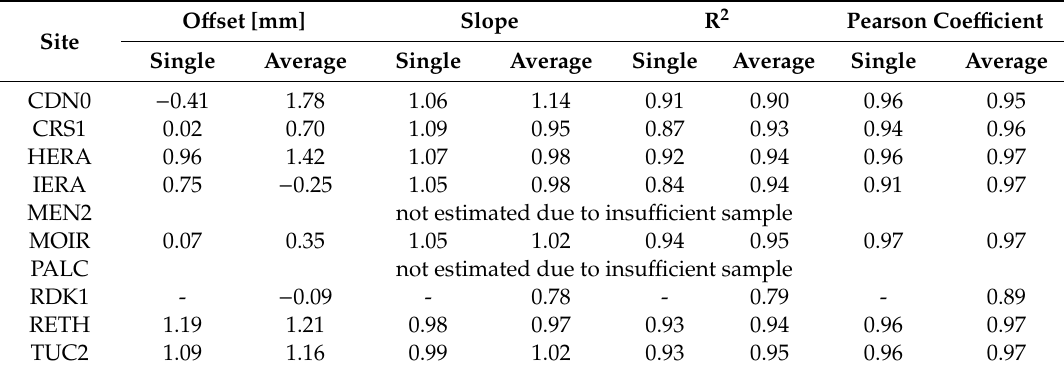
Table 6. Statistical analysis of the correlation between the Sentinel-3B OLCI and GNSS IWV values at the GNSS stations over the study area. The confidence level for regression analysis is 95% while in all cases the Pearson p -value is <